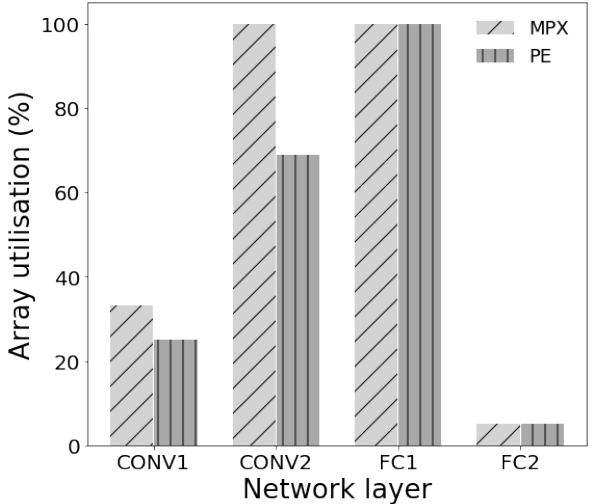
Figure 7. A bar plot comparing the utilisation of MPX-p across the MPA as well as the utilisation of processing elements with the MPX-p for each layer of the model.